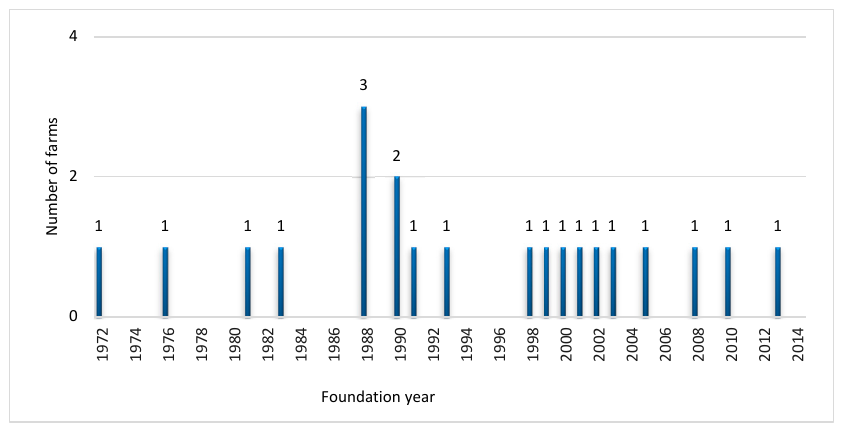
Figure 1. Number of quail game farms according to the year of establishment (n = 21).